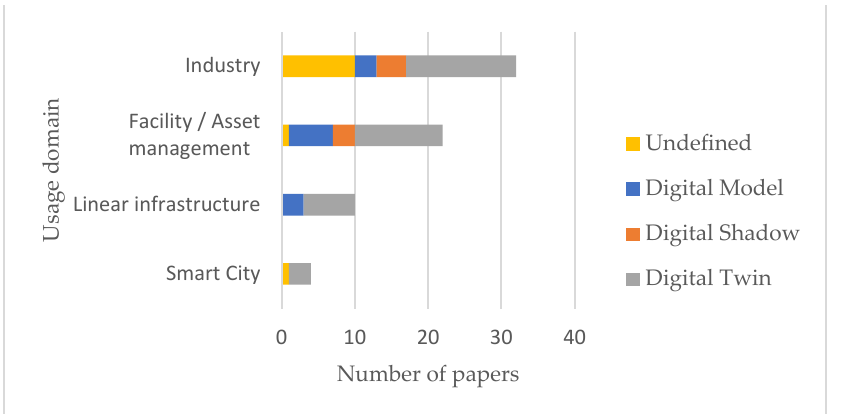
Figure 15. Main usage domains of the different DT types.